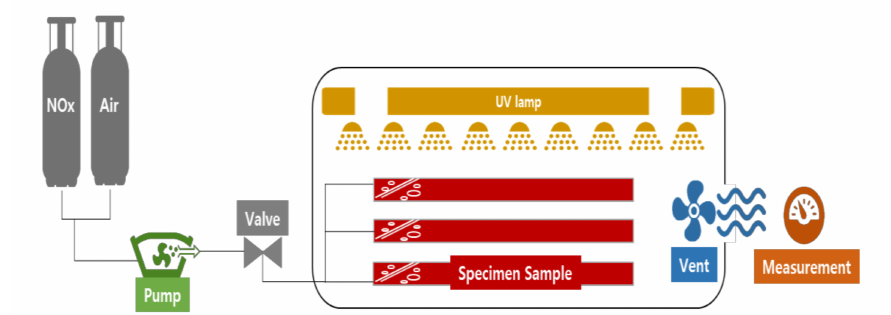
Figure 6. Schematic representation of the experimental setup.